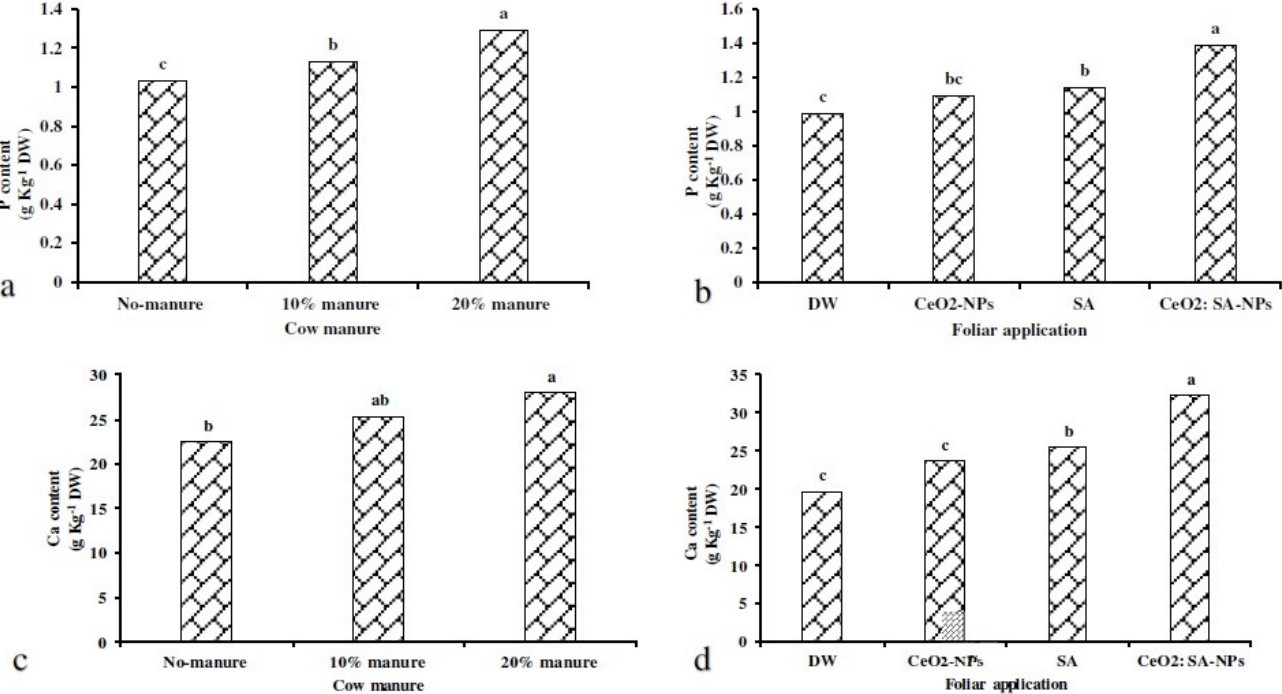
Figure 6. The effects of soil-based animal manure application (0%, 10%, and 20% v / v ) on P ( a ) and Ca ( c ) content, and the foliar spray of distilled water (DW), salicylic acid (SA), cerium oxide nanoparticles (CeO 2 -nanoparticles), and cerium oxide salicylic acid nanoparticles (CeO 2 : SA-nanoparticles) on P ( b ) and Ca ( d ) content of Aloe vera L. plants. Significant differences among treatments are indicated by the different Latin letters.